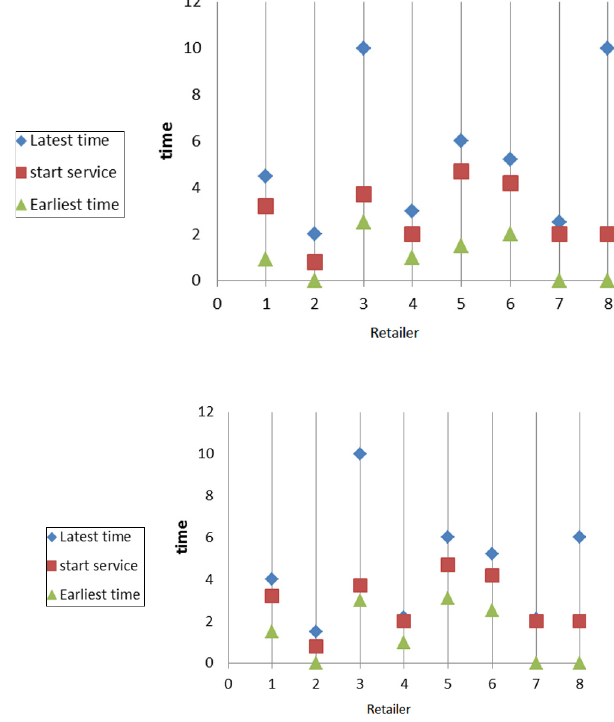
Figure 6. Compliance check for hard time windows